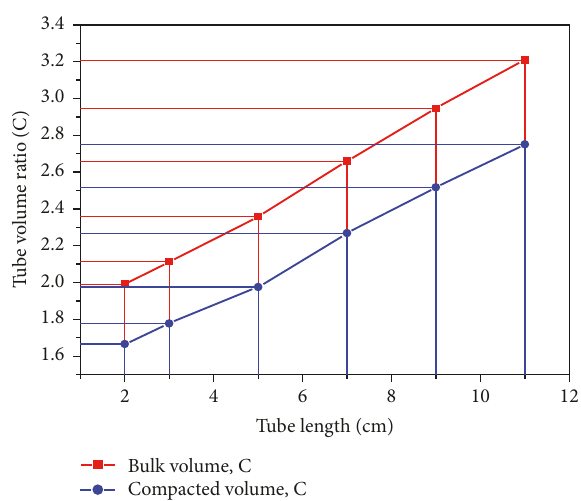
Figure 8: Tube volume ratio as a function of tube length.